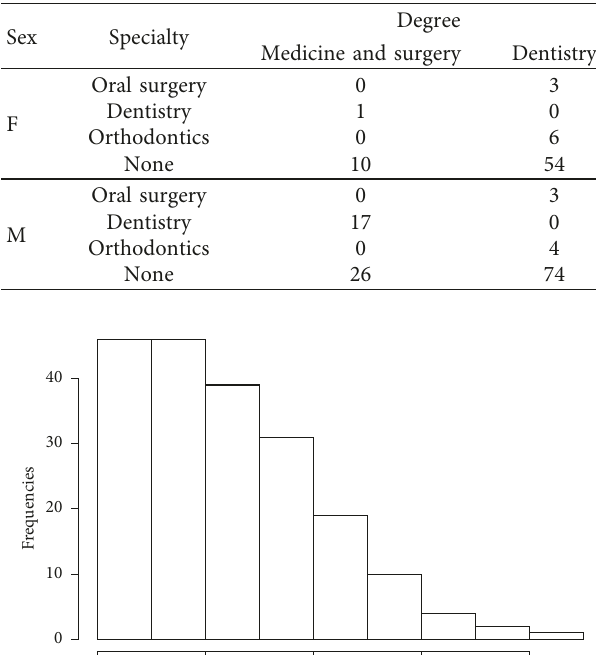
Table 2: Joint distribution of sex, specialty, and degree.